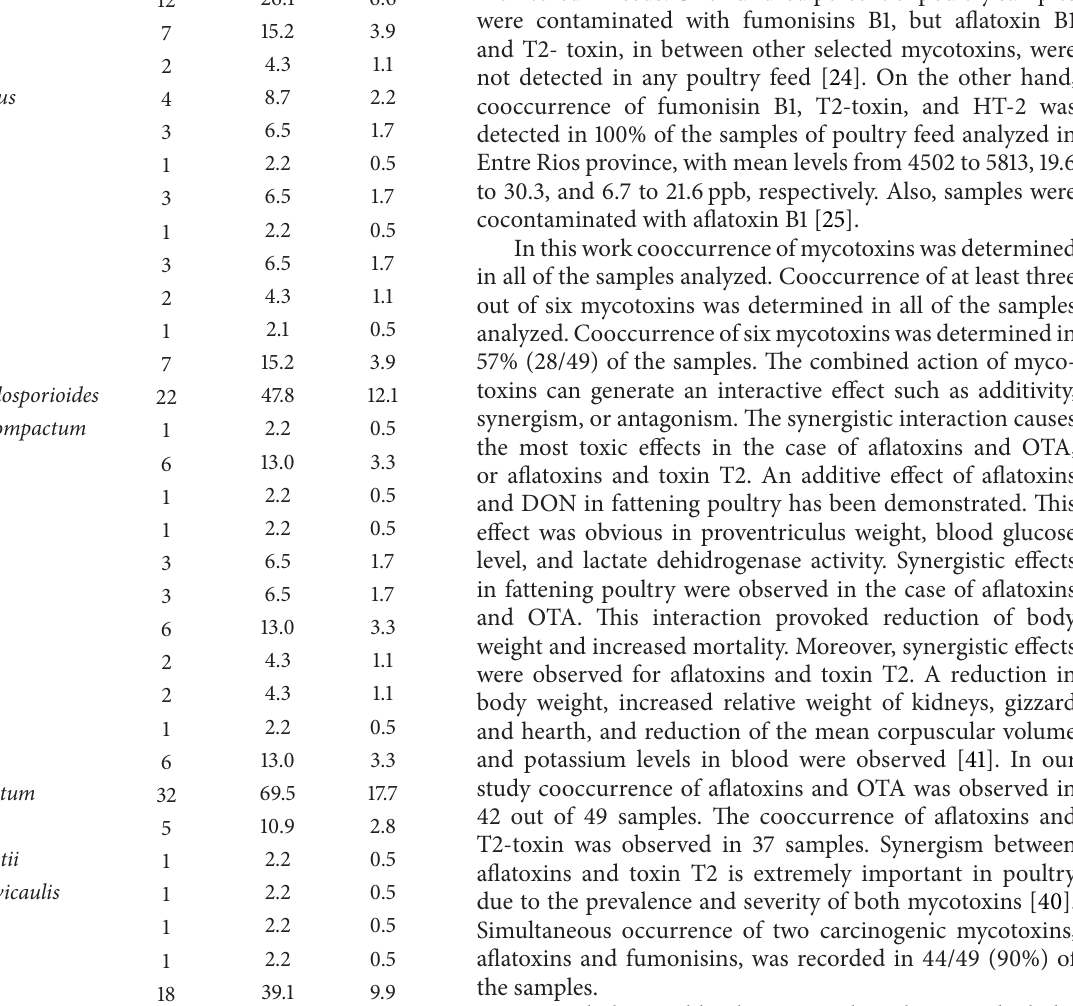
∗ Isolation frequency. ∗∗ Isolation relative